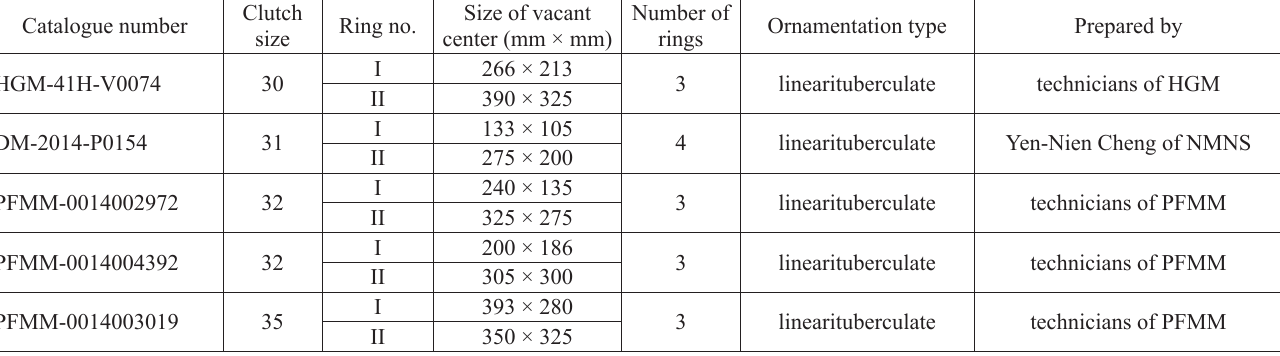
Table 2. Characteristics of the complete clutches from the Nanxiong Formation of China described in this study. I, innermost ring; II, second